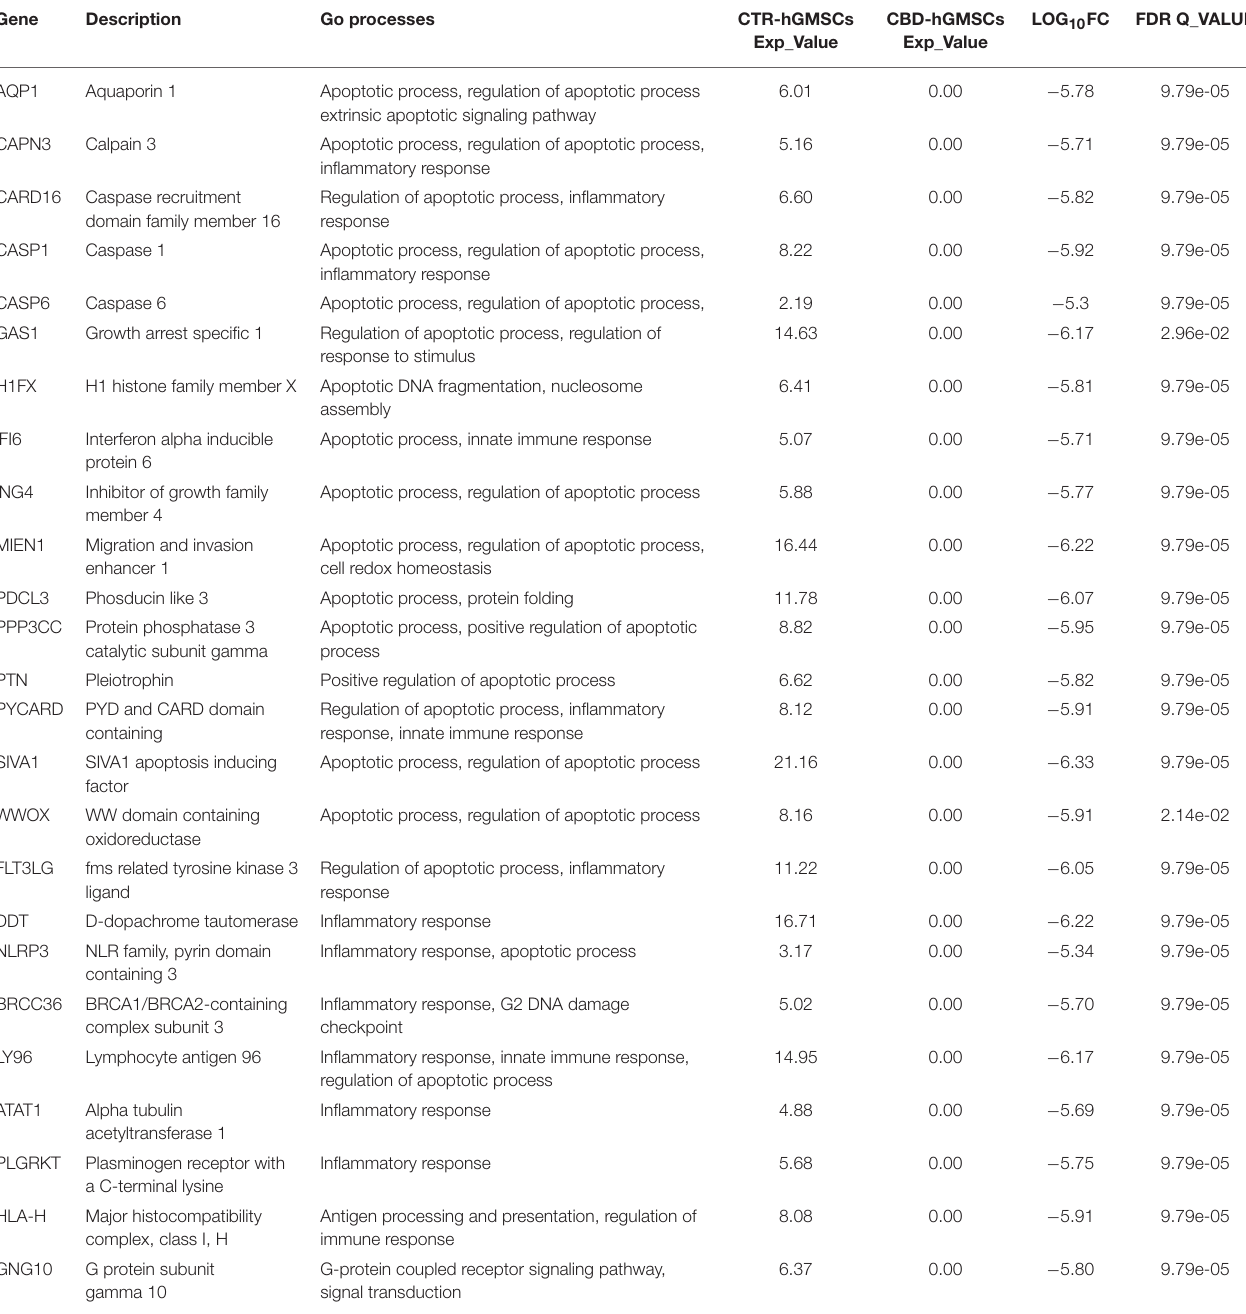
TABLE 1A | CBD treatment suppressed genes linked to apoptosis, inflammatory and innate immune responses. Gene